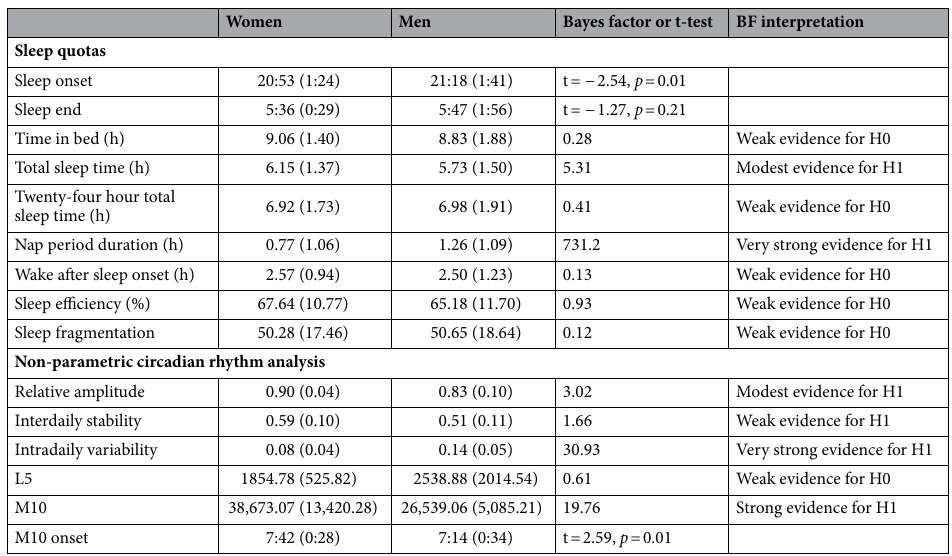
Table 4. Descriptive sleep quotas (n = 51, men = 23) and NPCRA analysis (n = 31, men = 17) comparing women and men in the BaYaka study sample. Data are reported as mean (standard deviation). Bayes factor is reported to assess differences in sleep quotas between genders. Time value difference (sleep onset, sleep end, and M10 onset) is assessed using a